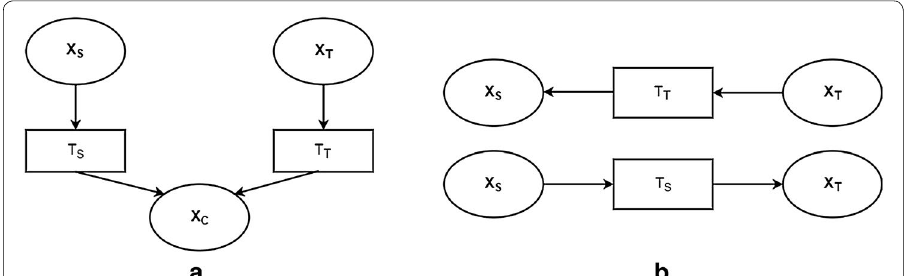
Fig. 1 Illustration of symmetric ( a ) and asymmetric ( b ) feature transformation for